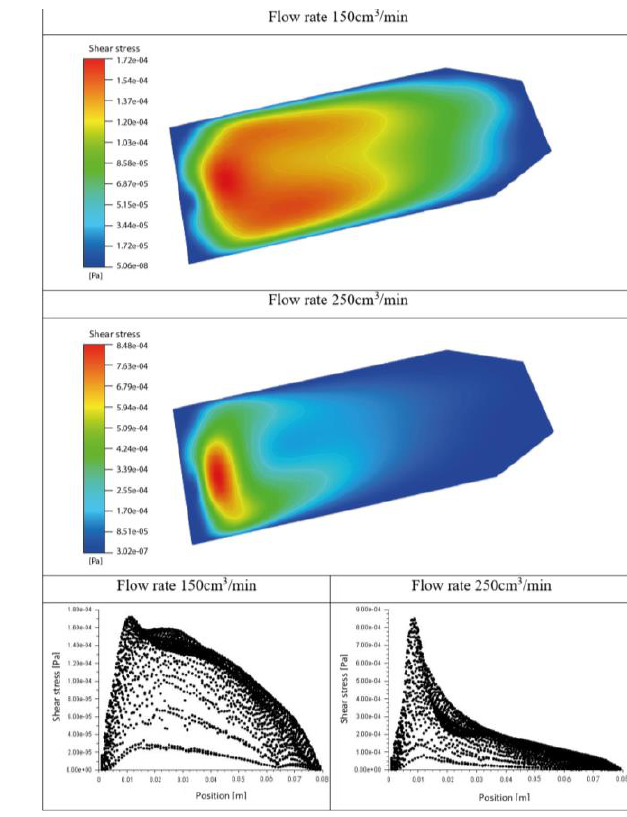
Fig. 6. Maps and diagrams of shear stress distribution on the bottom wall of the specimen for model 2